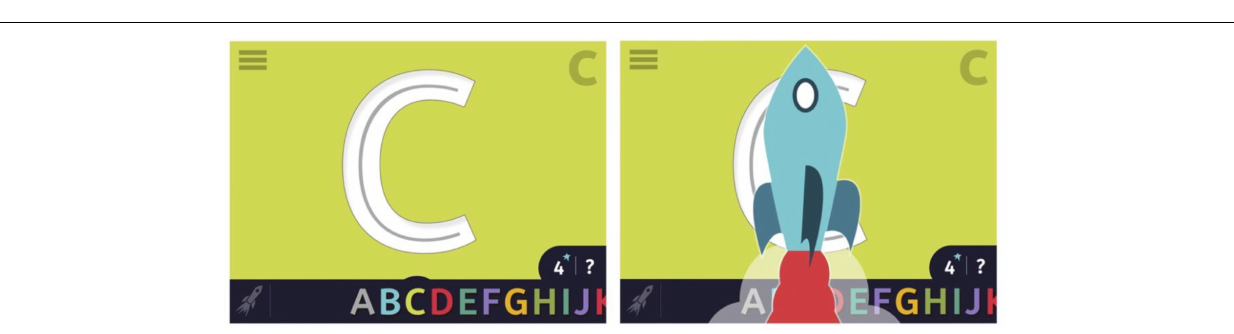
FIGURE 10 | Various sketches from children during User Study 1 showing fireworks and “thumbs up” as well as checkmarks and messages requesting “points” or badges.